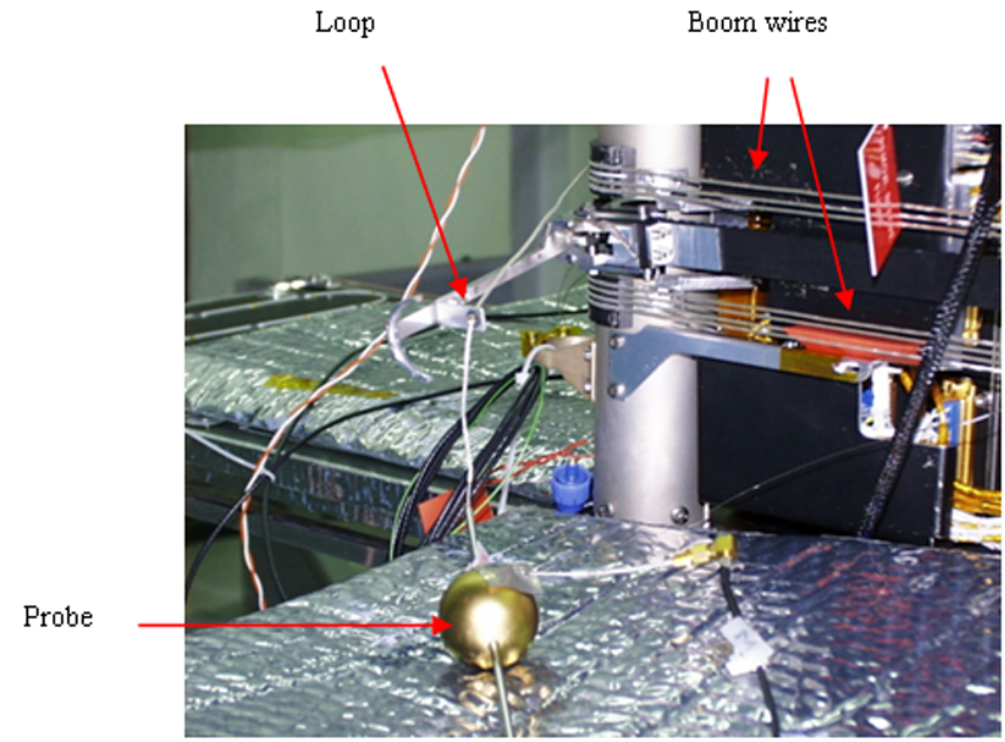
Fig. 4. The EMMA electric field probe and deployment